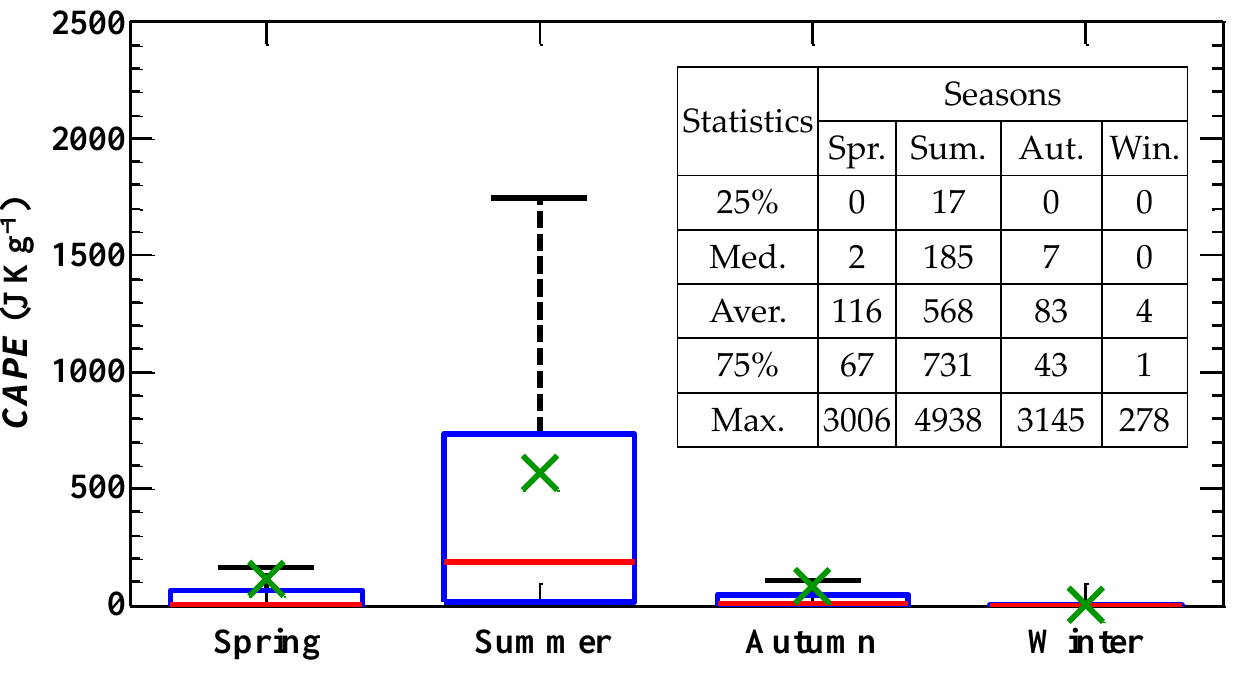
Figure 10. Boxplots of CAPEs (convective available potential energy) for four seasons. Corresponding statistics of percentiles (25%, Median, 75%), averages (Aver.), and maximums (Max.) are also listed in the figure.